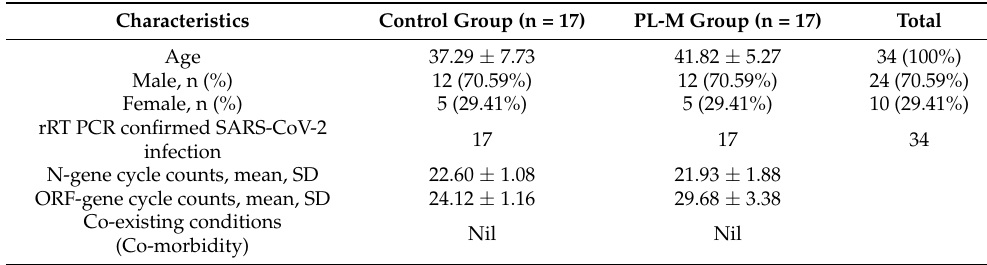
Table 1. Baseline